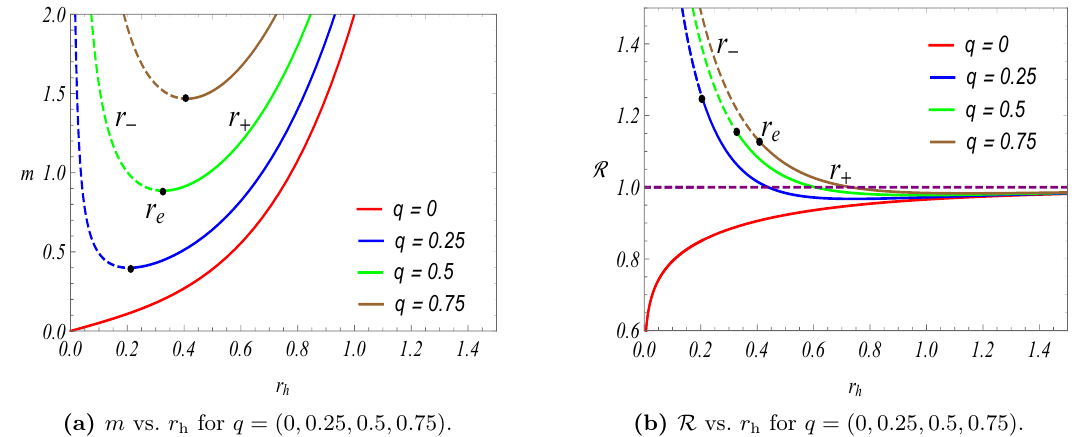
Figure 1 . The mass parameter m and isoperimetric ratio R vs. horizon radius r h and different numerical values of the electric charge parameter q with l = 1 . Solid/dashed lines correspond to outer/inner horizons, while black dots mark out the extremal horizons. Dashed horizontal purple line corresponds to R = 1